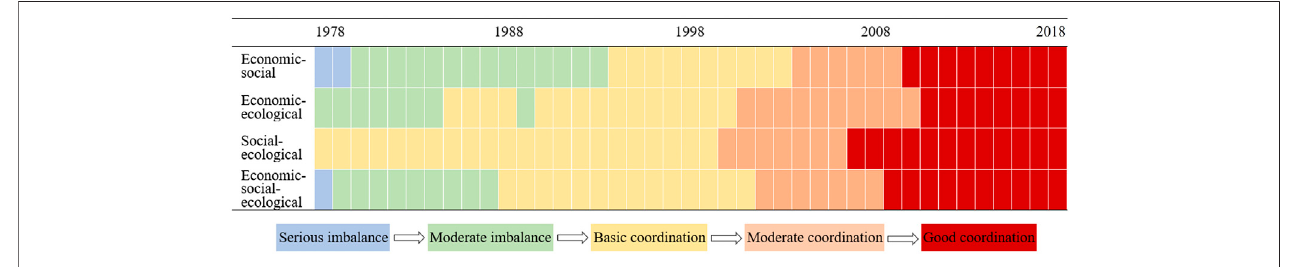
FIGURE 6 | Coupling coordination types of NRUBs from 1978 to 2018.